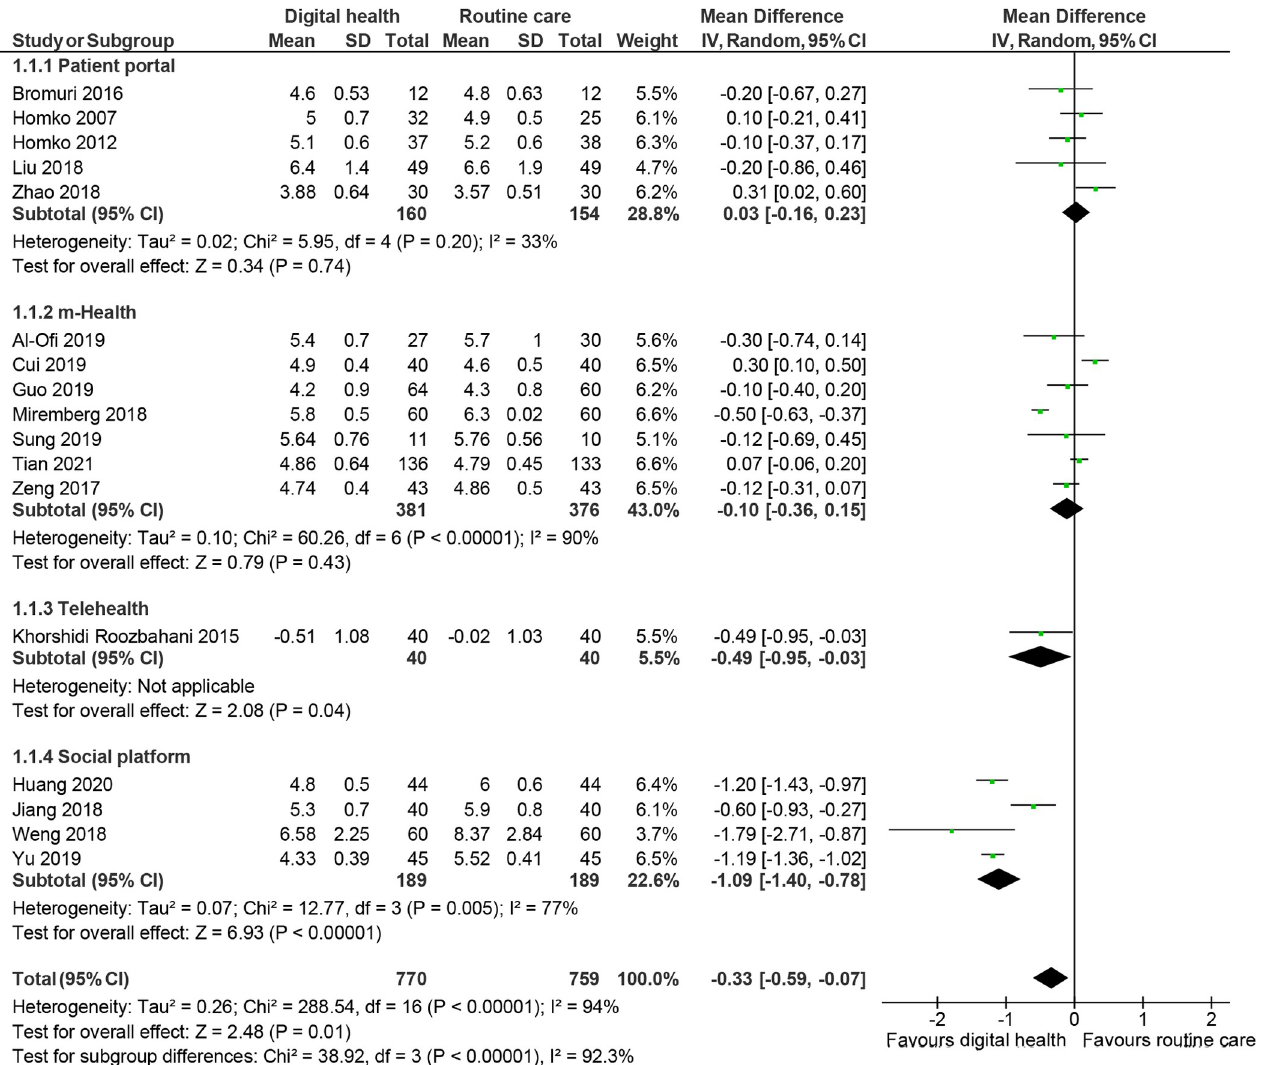
PLOS Digital Health | https://doi.org/10.1371/journal.pdig.0000015 February 24,